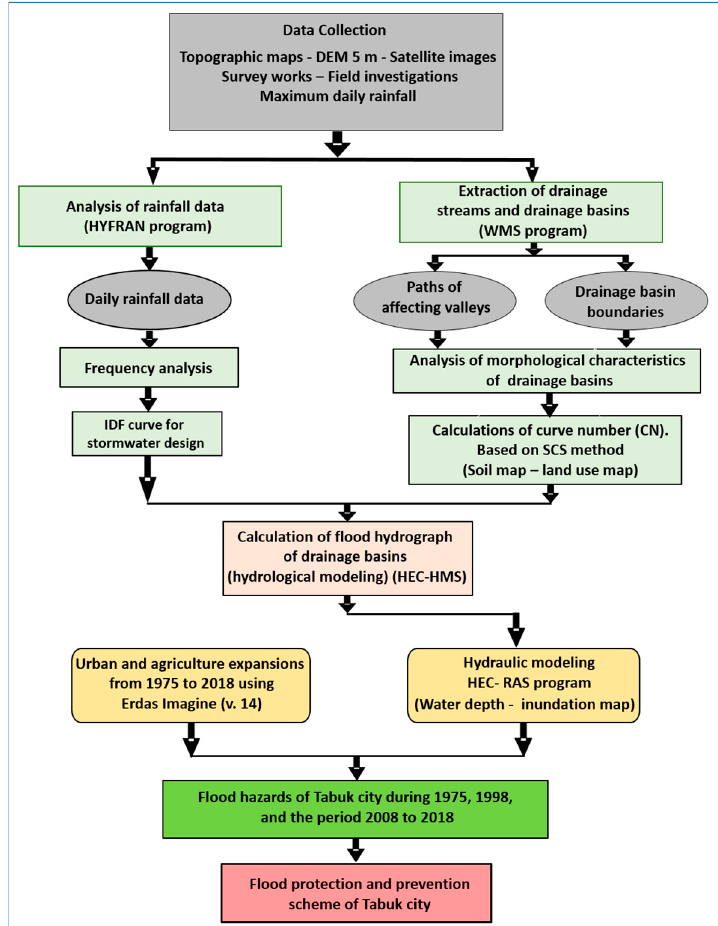
Figure 3. Flowchart showing the methodology adopted in the current work.